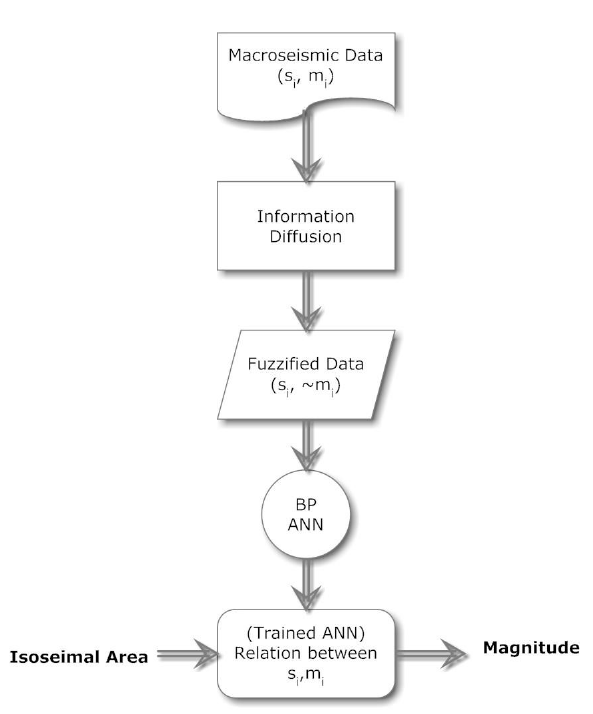
Fig. 7. System architecture of the hybrid neural-fuzzy network adopted in the present